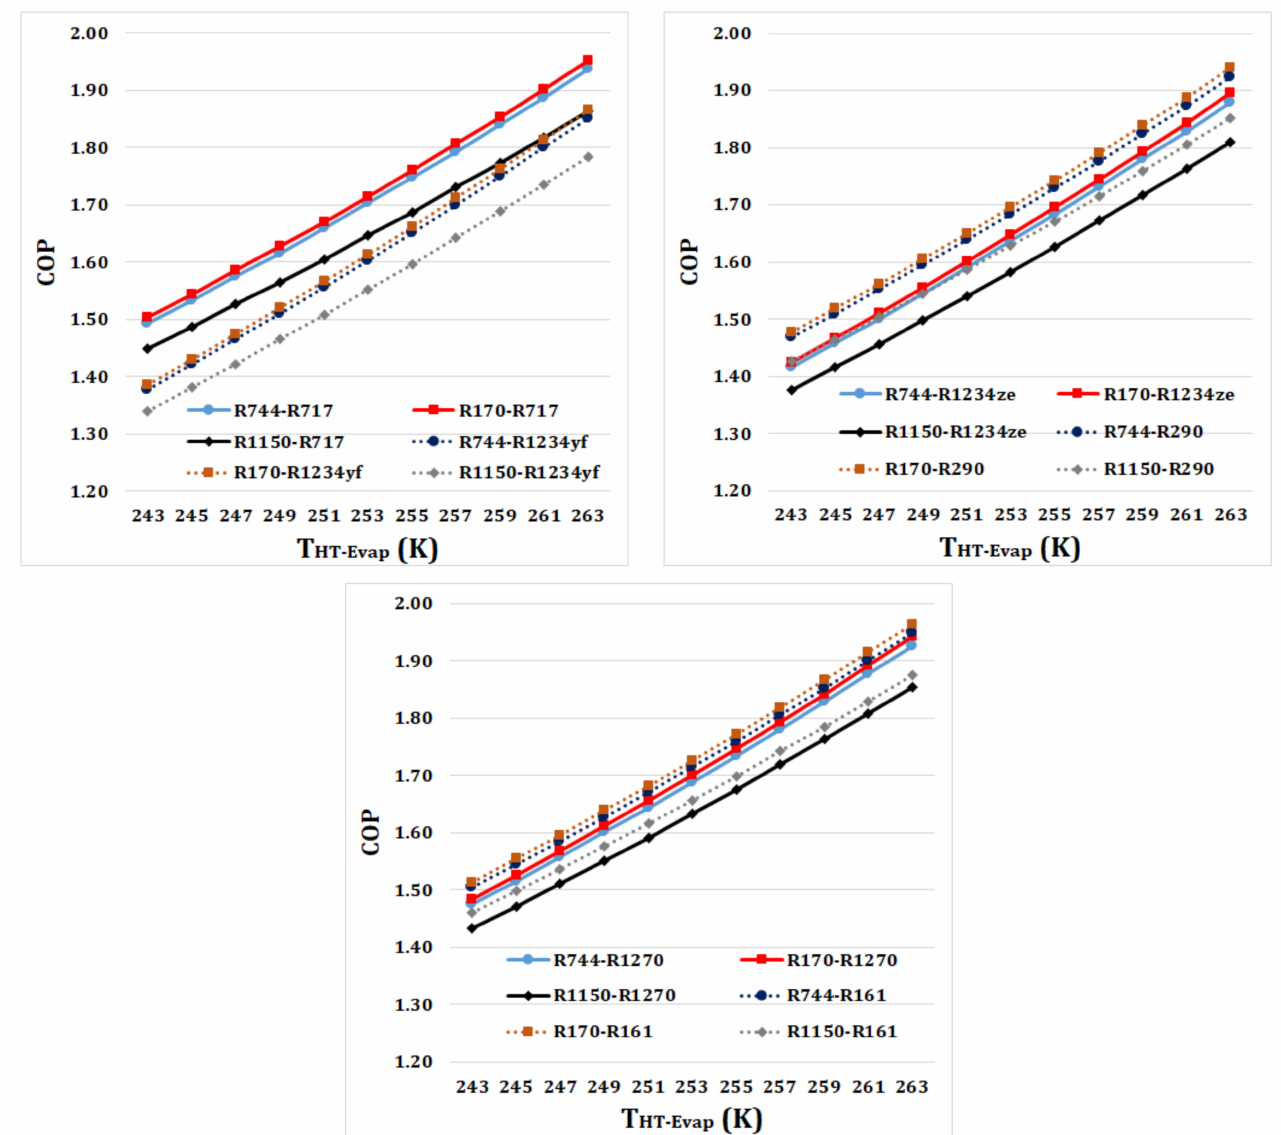
Figure 8. Effect of high-temperature evaporator ( T HT − Evap ) on the COP for different refrigerant